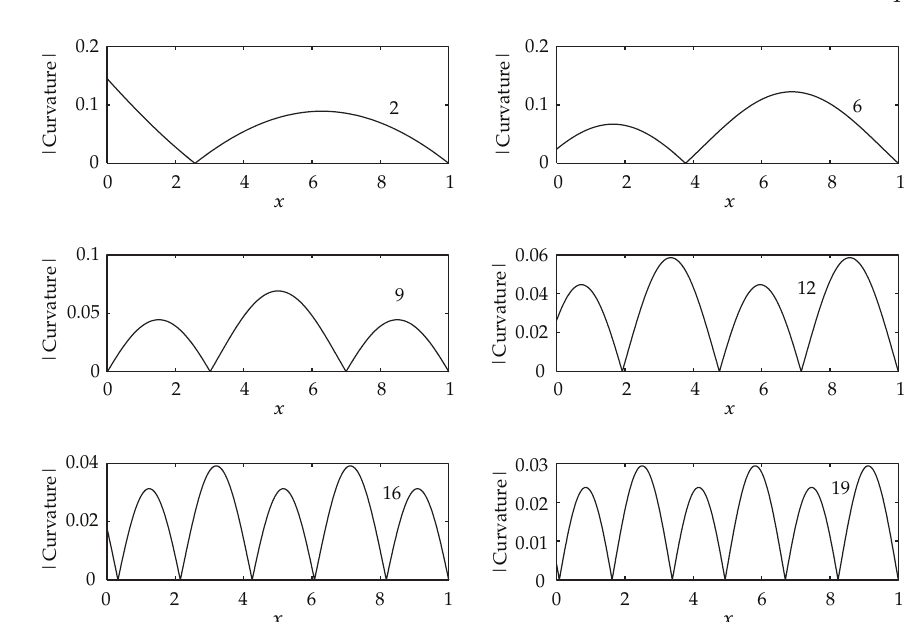
Figure 15: Graphs of the magnitude of the curvature for representative values of the beam number B in the intervals I 1 to I 6